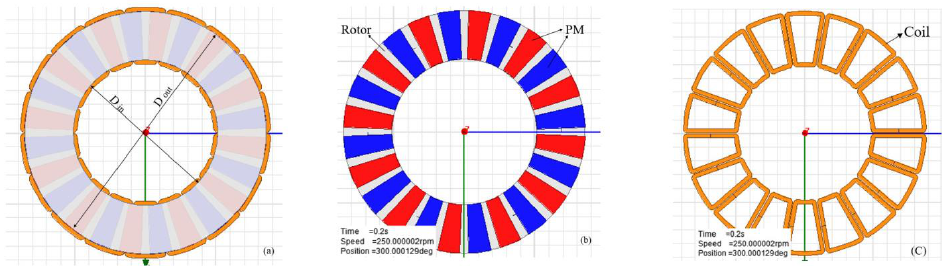
Figure 2. Structure of ironless AFPMSG: ( a ) general structure, ( b ) Rotor and PMs structure, and ( c ) ironless stator .